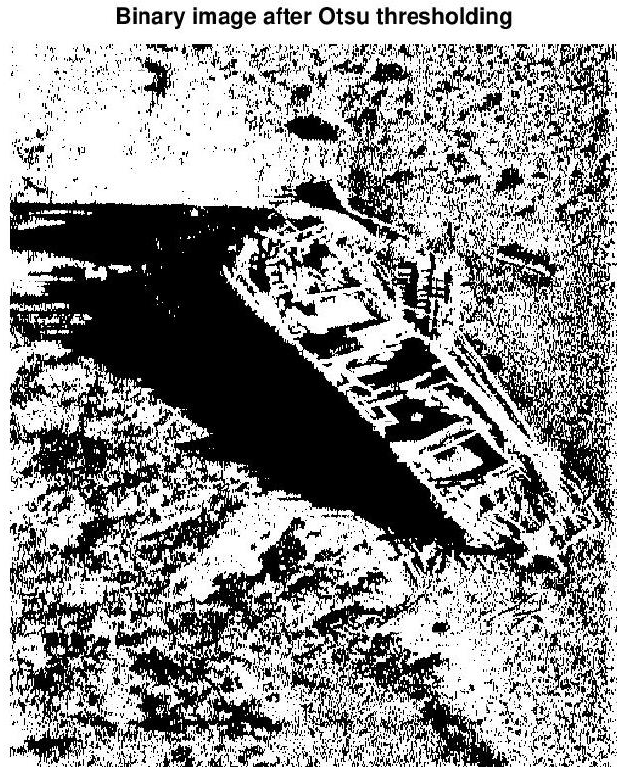
Figure 3. Binary image after Otsu’s